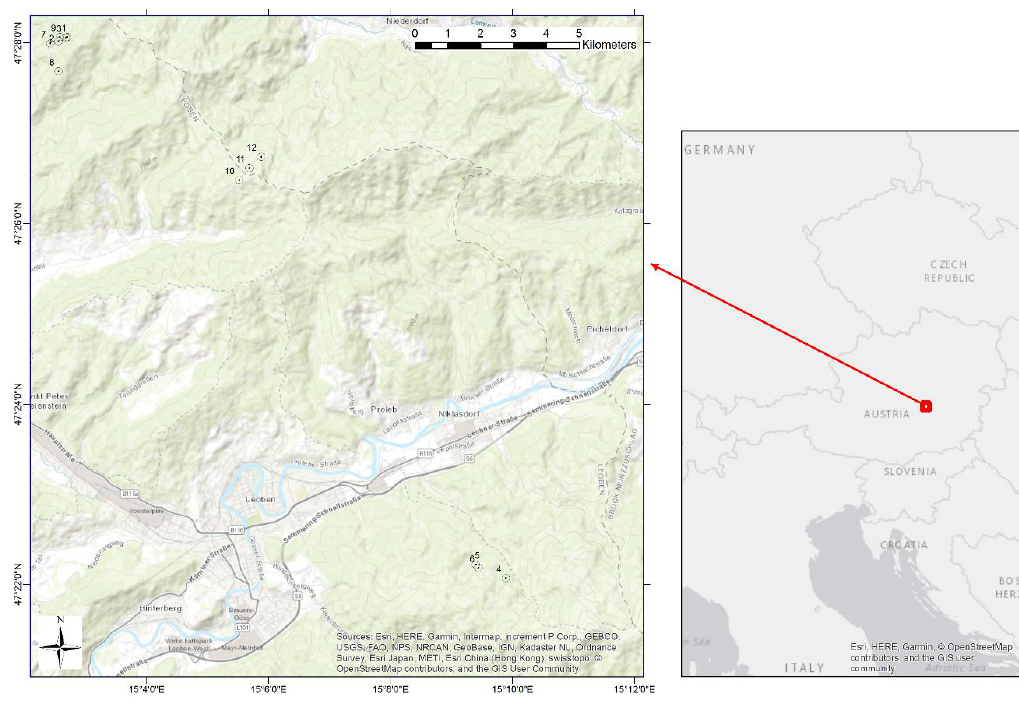
Figure 1. Location of the twelve sample plots.